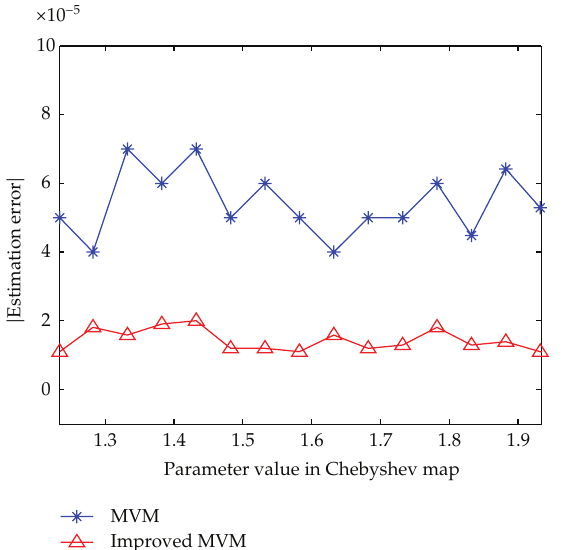
Figure 6: The estimation error of MVM in (cid:5) 8 (cid:6) and the improved MVM proposed in this paper for Chebyshev